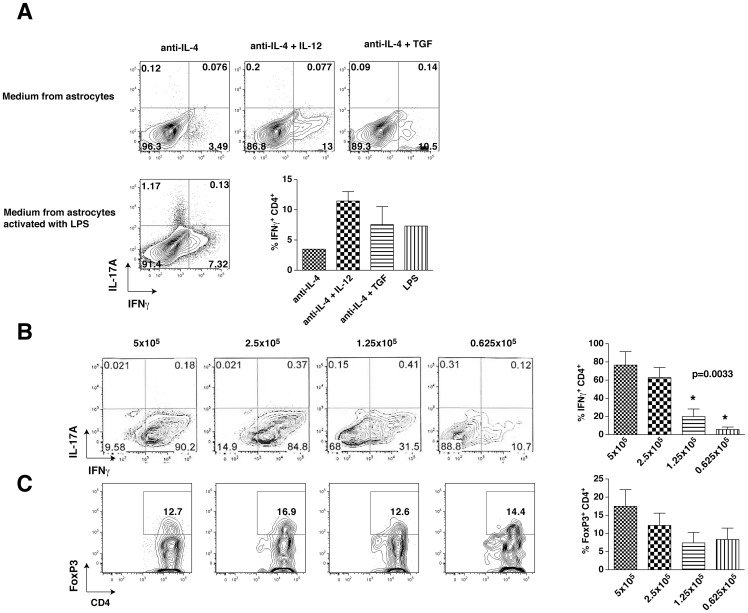
Cross-talk between Th1 cells and astrocytes is necessary to promote maximal Th1 differentiation.(A) CD4+ T cells were polarized toward Th1 cells for 4 days in conditioned medium from unstimulated or LPS-stimulated astrocytes supplemented with 10 ng/mL IL-12 (Th1) or 5 ng/mL TGFβ (Treg). Cells were washed and stimulated for 4 h with PMA/ionomycin/BFA and IFNγ-producing CD4+ T and Foxp3 expressing CD4+ T cells were analyzed by flow cytometry. Flow cytometry analyses were quantified and expressed as mean ± s.e.m. (n = 2). (B–C) Different quantities of CD4+ T cells were cultivated on an astrocyte monolayer and polarized toward (B) Th1, or (C) Treg cells for 4 days in medium supplemented with 10 ng/mL IL-12 (Th1), or 5 ng/mL TGFβ (Treg). Cells were washed, stimulated for 4 h with PMA/ionomycin/BFA, and IFNγ-producing and Foxp3-expressing CD4+ T cells were analyzed by flow cytometry. Flow cytometry analyses were quantified and expressed as mean ± s.e.m. (n = 3, , one-way ANOVA test, *p<0.05 compared to 5×105 cells).